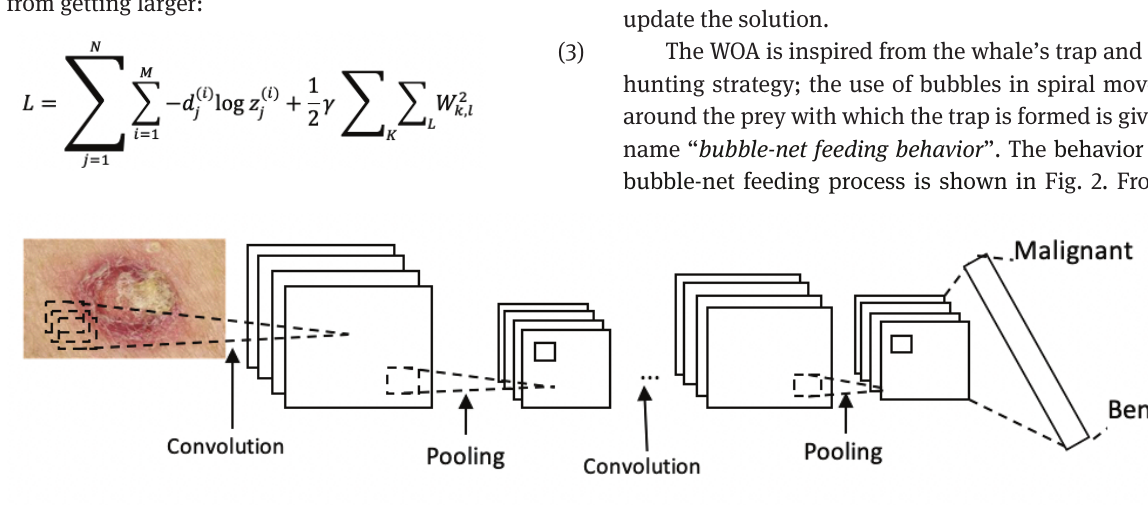
Figure 1: A simple skin cancer detection using ordinary